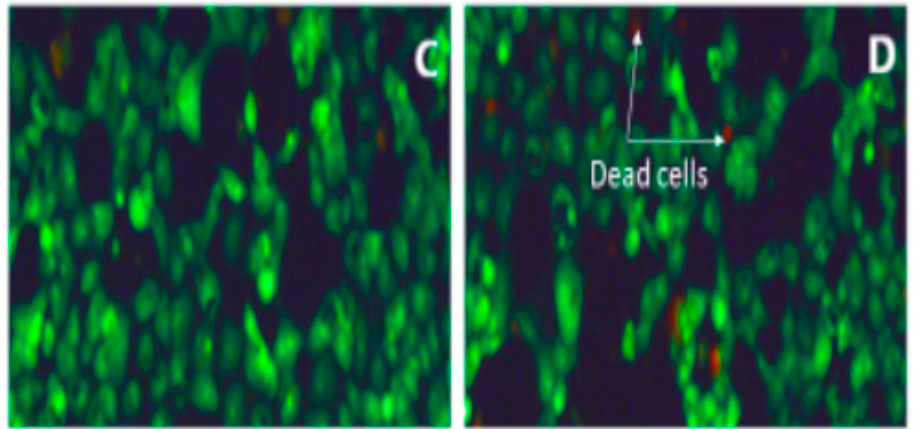
Figure 2. Representative fluorescence images of AO / PI-stained OVCAR-3 cells untreated and treated with VC F7. Live cells are stained in green and dead cells are stained red. ( A )—Control, ( B )—8 µ g / mL, ( C )—16 µ g / mL, ( D )—32 µ g / mL. All fluorescence images were captured under 20× optical resolution of the microscope.